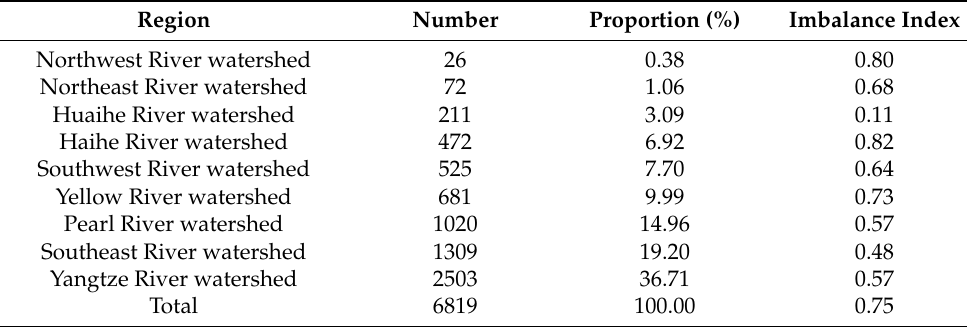
Table 2. Imbalance index of traditional villages in China and each first-level watershed. Region Number Proportion (%) Imbalance Index Northwest River watershed